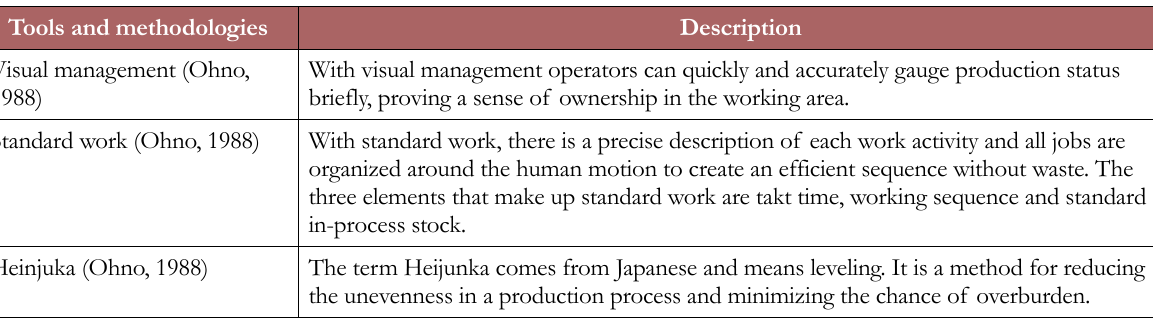
Table 2. Lean tools and methodologies